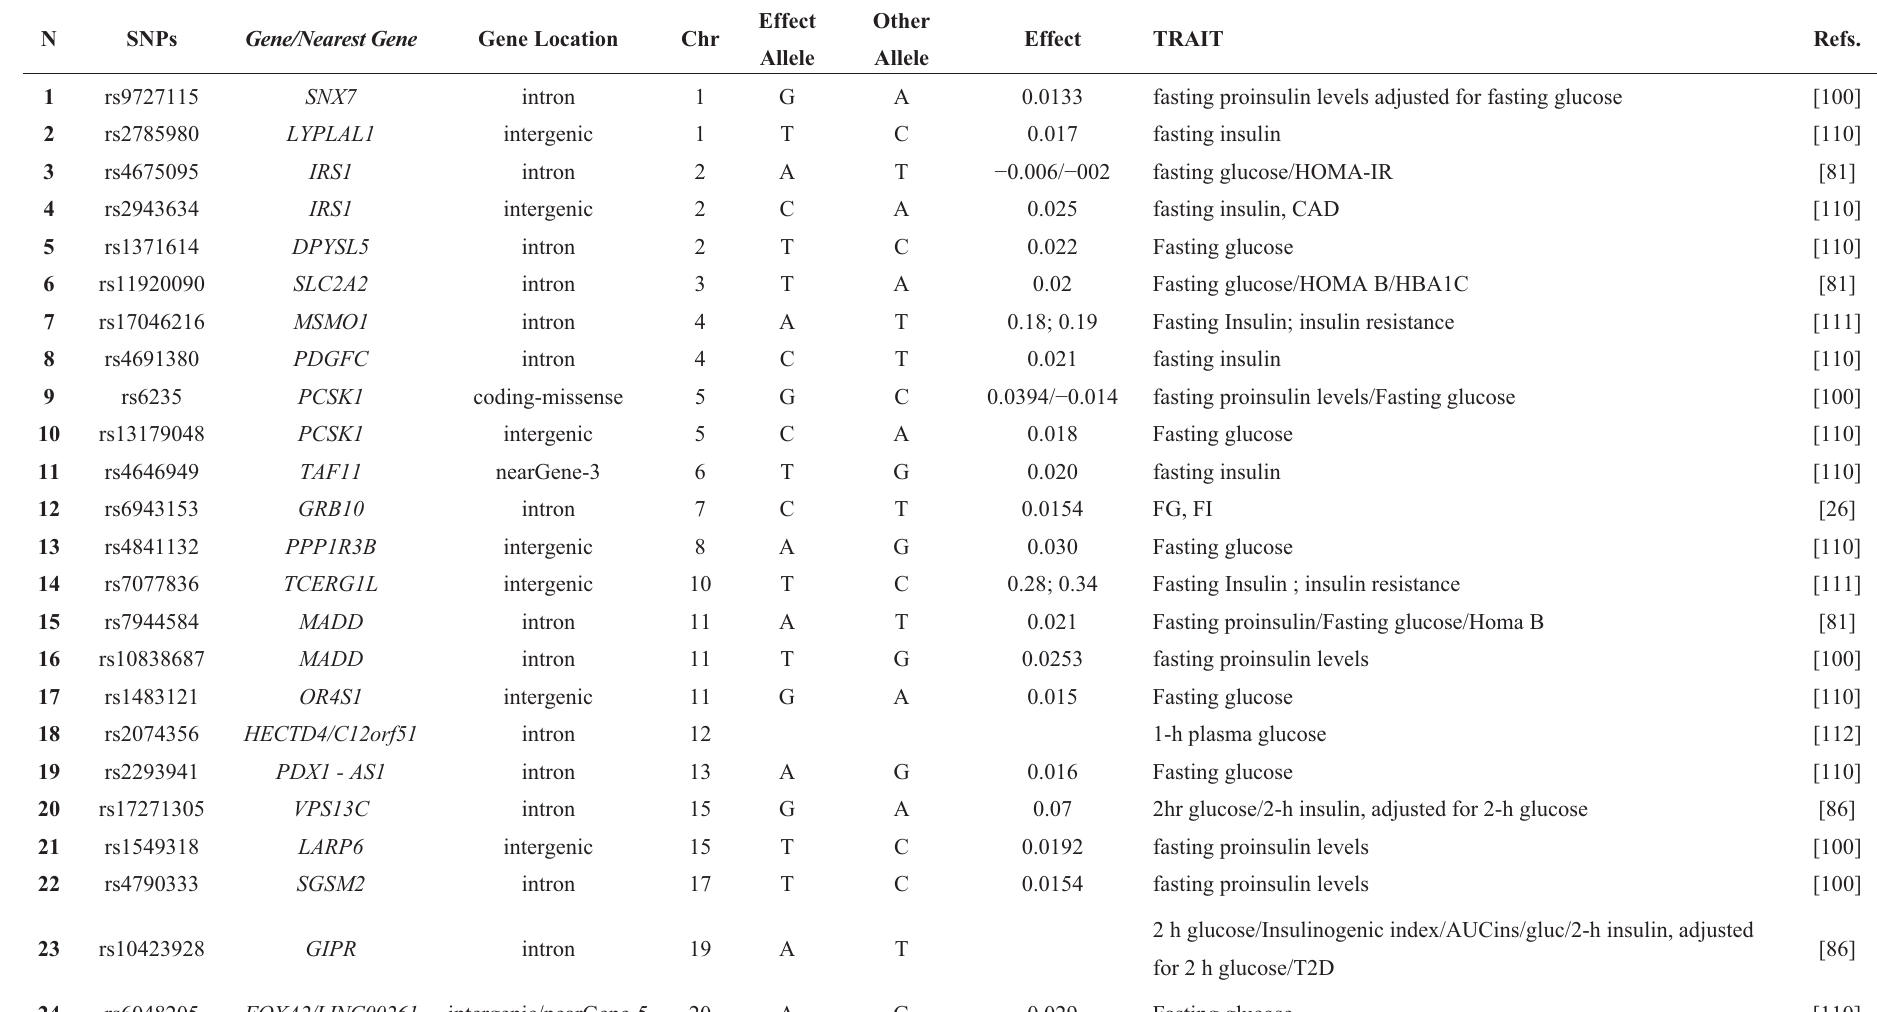
Table 2. Genetic loci associated with glycemic